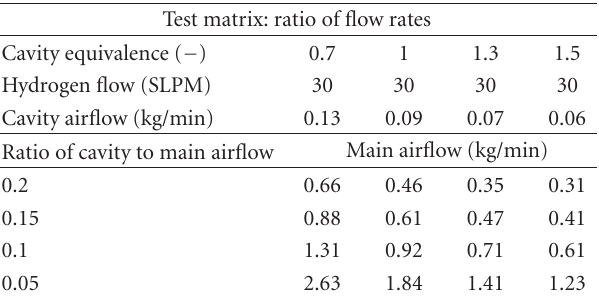
12 millimeters as measured from the combustion chamber (curved channel). The total width of the main channel is 14.3 mm.